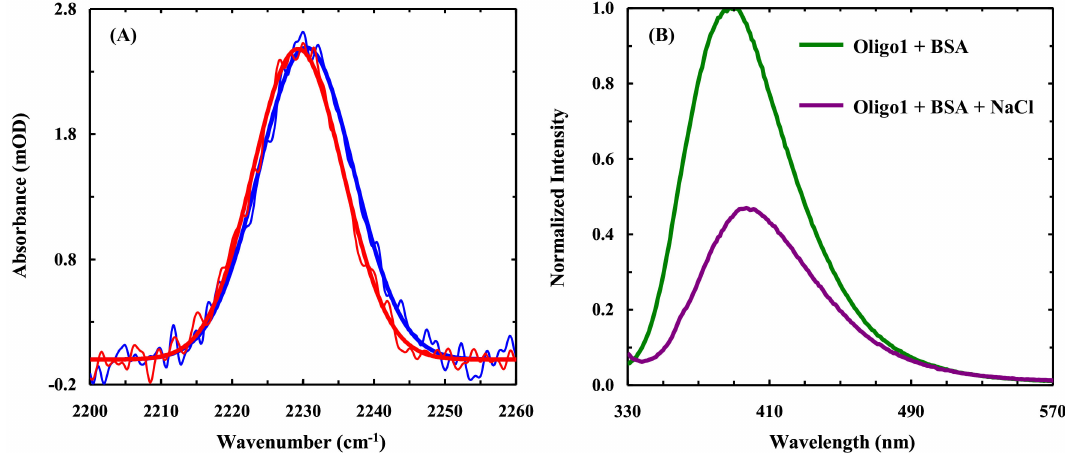
Figure 8. ( A ) Comparison of the C ≡ N stretching bands of Oligo1 obtained in the presence (red) and absence (blue) of BSA. (B ) Normalized fluorescence spectra of an Oligo1-BSA mixture in the presence and absence of 2 M NaCl, as